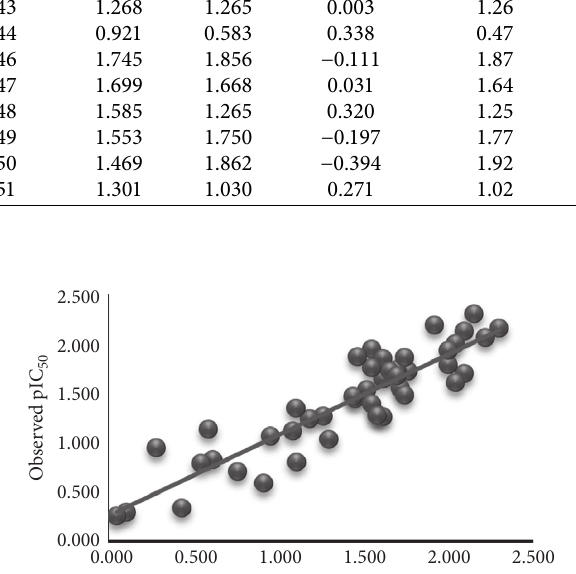
50 values using